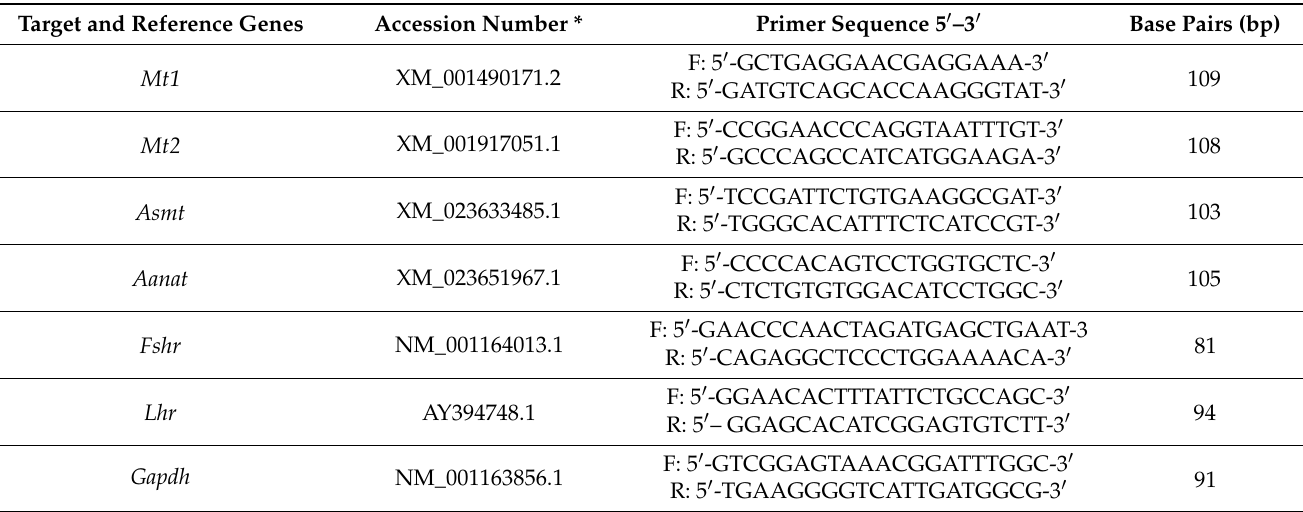
Table 1. List of qRT-PCR primers used in this study.